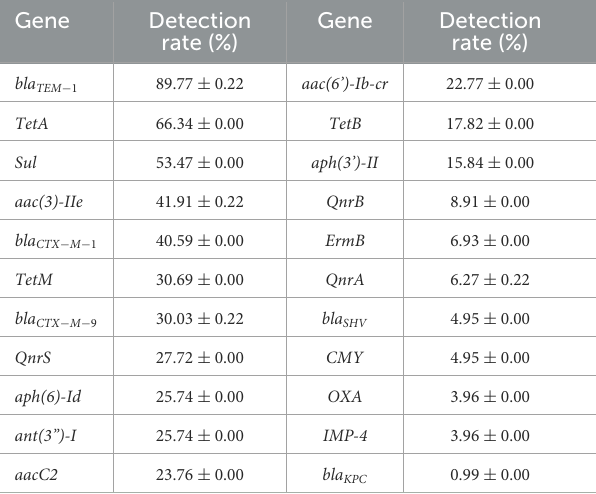
TABLE 1 Detection rate of drug-resistance genes ( n =